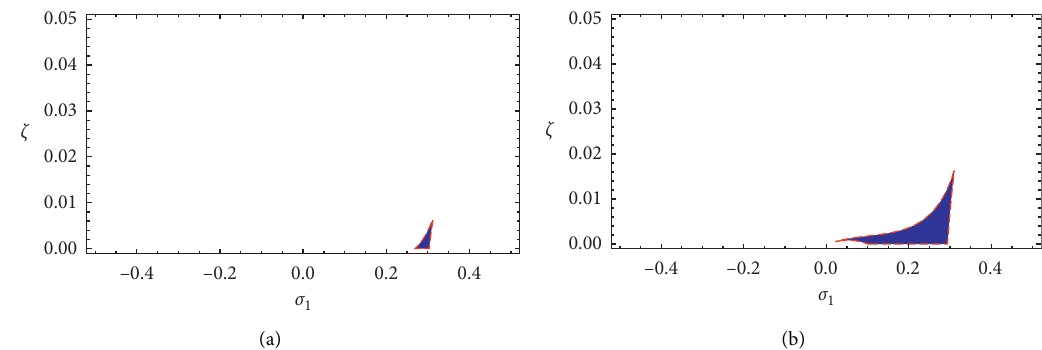
Figure 10: The system solution behavior in ζ − σ system with τ � τ